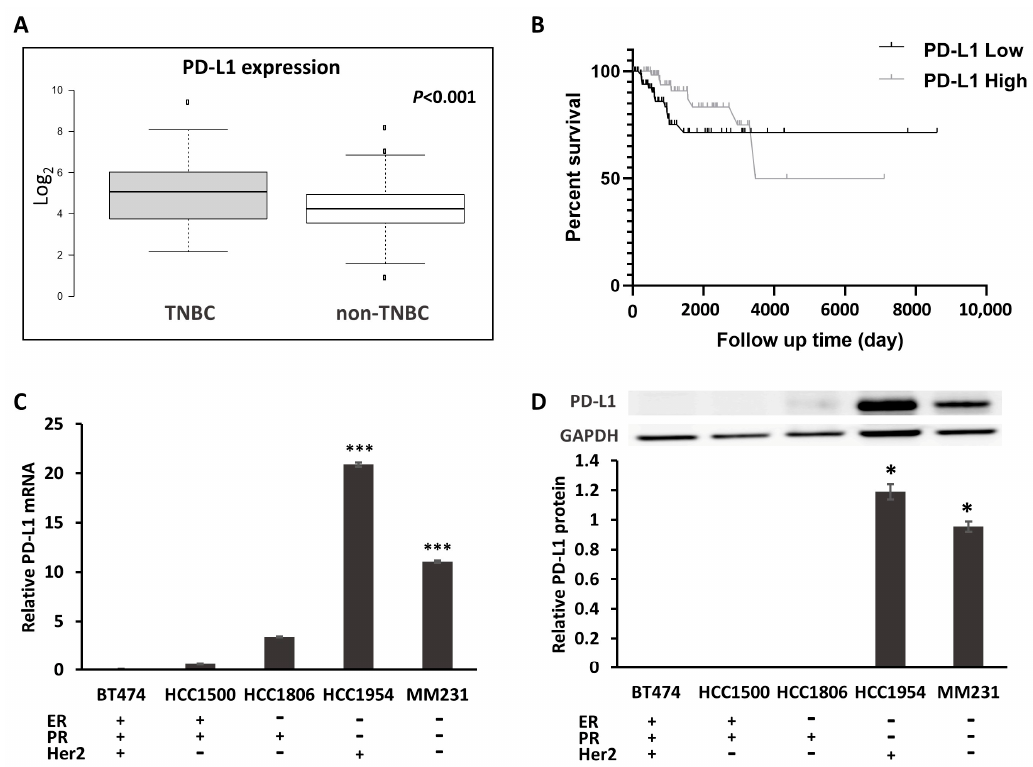
Figure 1. The expression of PD-L1 in TNBC. ( A ) Box plot (from 826 cases of breast cancer downloaded from TCGA) generated using BoxplotR (http://shiny.chemgrid.org/boxplotr/). Center lines show the medians; box limits indicate the 25th and 75th percentiles as determined by R software; whiskers extend 1.5 times the interquartile range from the 25th and 75th percentile, outliers are represented by dots. n = 214, 612 sample points. ( B ) Kaplan–Meier overall survival analysis (from 214 TNBC cases of breast cancer downloaded from TCGA). p = 0.0329. ( C ) mRNA expression of PD-L1 in breast cancer cell lines. ( D ) The protein expression of PD-L1, compared with the normal breast epithelial MCF-10A cell line. * p < 0.05, *** p <